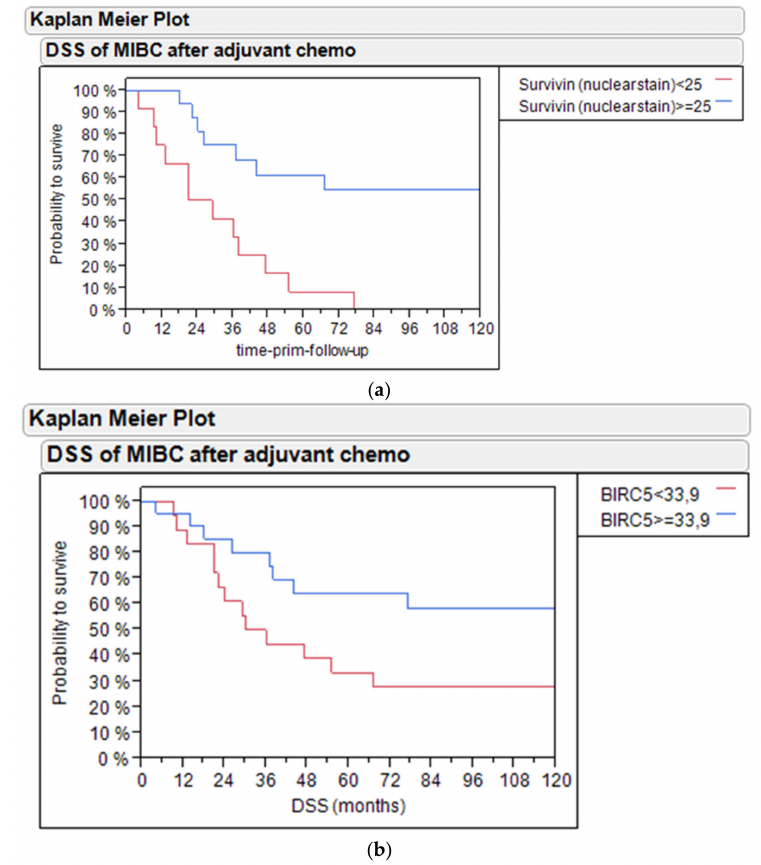
Figure 5. ( a ) Disease-specific survival (DSS) of bladder cancer patients treated with adjuvant chemotherapy based on survivin nuclear stain in the PCR and IHC cohort. ( b ) DSS of bladder cancer patients treated with adjuvant chemotherapy based on BIRC5 mRNA expression in the PCR cohort. Table 2. Pearson correlation of KRT5 , KRT20 , ERBB2 , BIRC5 , and CD68 mRNA levels with performance status (PS), age, sex, body mass index (BMI), presence of carcinoma in situ (Cis), tumor size (T-prim), and WHO Grade 1973 (G-prim) levels in the PCR cohort of bladder cancer patients treated with adjuvant chemotherapy. Blue values indicate positive associations of significance, red values indicate negative associations of significance, and black values indicate insignificant